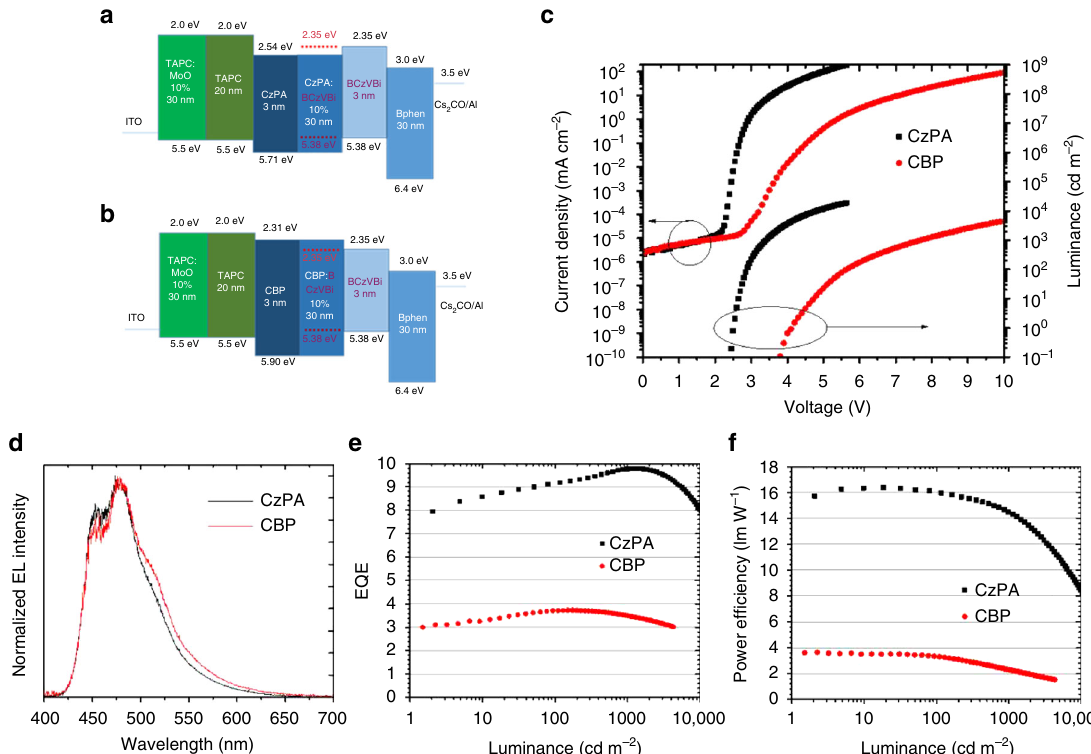
Fig. 6 Multilayer OLEDs. Performances of the devices using CzPA and CBP as hosts vs the optimized device using CzPA as host. a , b Device structures. c Current density and luminance versus voltage of the devices. d – f EL spectra, EQE-luminance characteristics and power ef fi ciency-luminance characteristics of the achieves a luminance of 0.1 cd/m 2 at 2.4 V, 100 cd/m 2 at 2.9 V and 1000 cd/m 2 at 3.4 V, respectively, as shown in Fig. 6a. The EL spectra of the optimized device indicated no change as a function of voltage, as shown in Figure S6b.